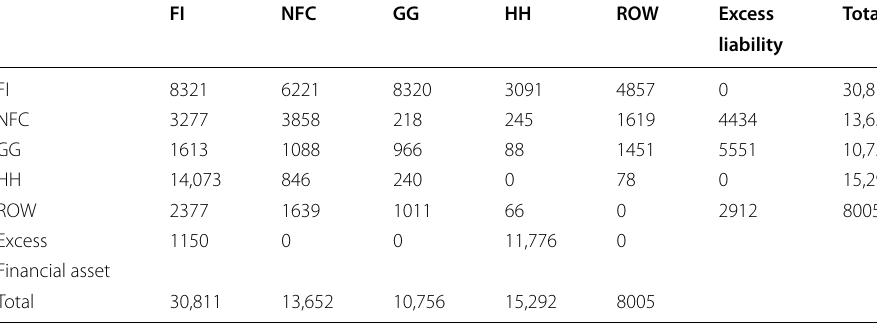
Source: created by authors using OECD.Stat